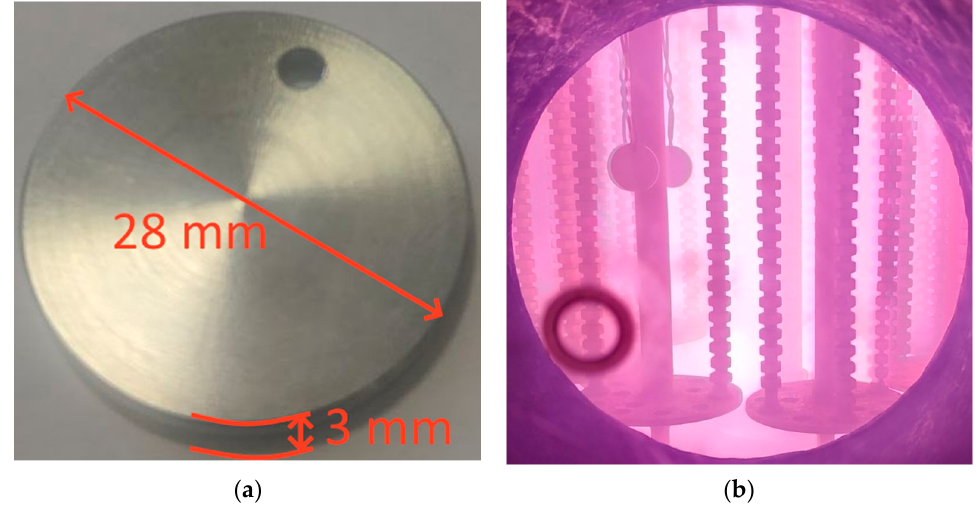
Figure 1. Optical microscopy image showing the dimensions of the sample ( a ) and the coating pro- cess ( b ). ing process ( b ).